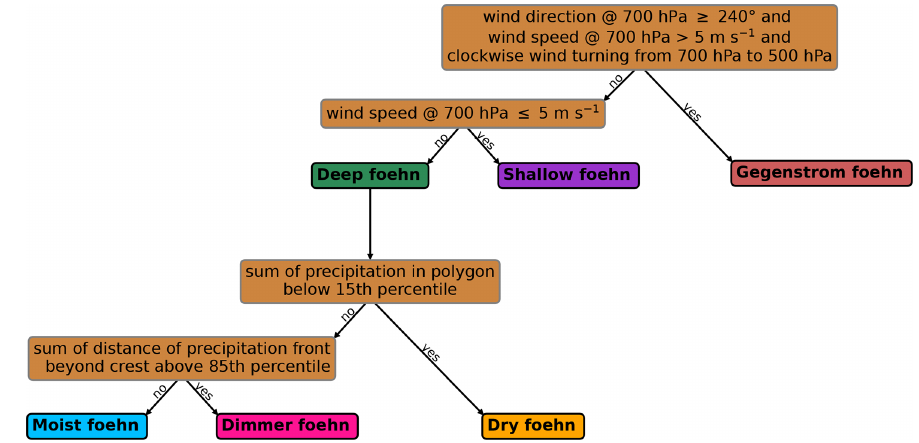
Figure 2. Sequential decision tree to classify the foehn hours into three main foehn types and three deep-foehn subtypes.